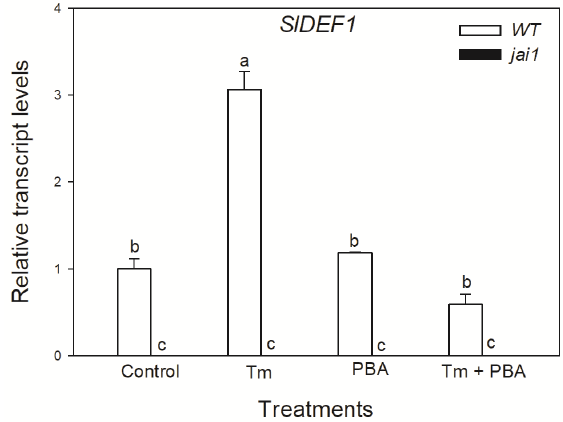
Figure 3. Changes in the transcript accumulation of SlDEF1 in the leaves of wild-type (WT) and JA signalling mutant (jai1) tomato plants exposed to 5 µ g mL − 1 tunicamycin (Tm), 1 mM 4-phenylbutyrate (PBA) and Tm + PBA for 6 h. Results are the means ± SE. Data with di ff erent letters indicate significant di ff erences at p < 0.05 level, n = 3.